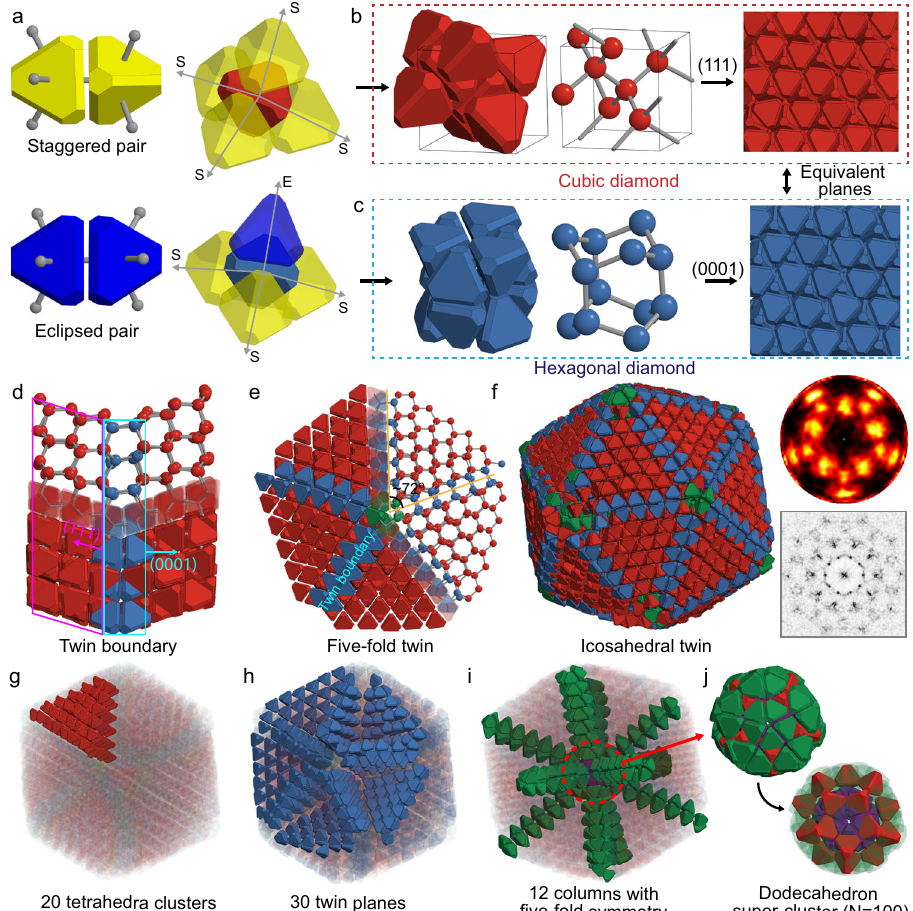
Fig. 1 | Twinned crystals of truncated tetrahedra. a Two types of pairwise con- tacts (left) and the local environment of particles in cubic diamond (upper right) andhexagonaldiamond(bottomright). b , c Unitcellsofcubicdiamond( b ,leftand middle) and hexagonal diamond ( c , left and middle) crystals. The (111) plane of cubicdiamond( b ,right)andthe(0001)planeofhexagonaldiamond( c ,right)have the same structure. d – j Twinned structures ofTTs. Redparticles are S 4 E 0 , blue are S 3 E 1 ,greenareS 2 E 2 andpurpleareS 1 E 3 . d Atwinboundaryisformedwhenthe(111) plane of cubic diamond (magenta arrow) and the (0001) plane of hexagonal